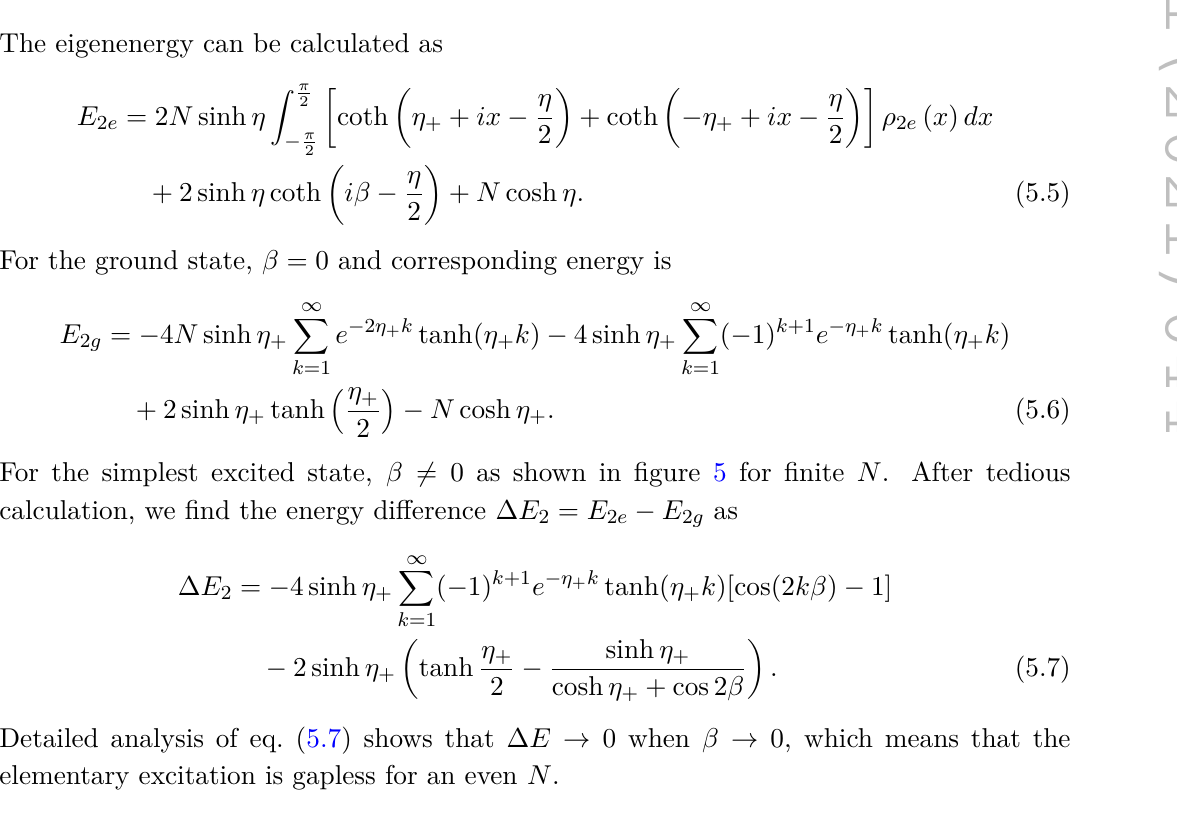
Figure 4 . (a) The distribution of z zero roots at the ground state for N = 10 and η = 0 . 75+ iπ . (b) The difference δE 2 g between the ground state energy calculated from eq. (5.6) and that obtained via numerical exact diagonalization. The data can be fitted as δE 2 g = 3 . 429 N − 1 . 073